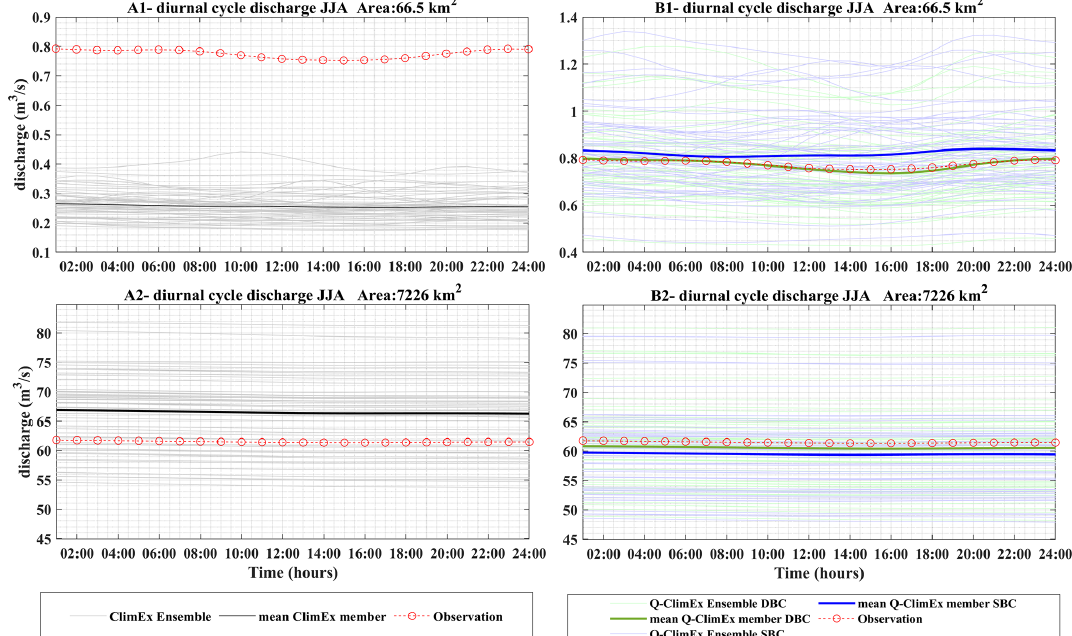
Figure 10. Annual diurnal cycle of discharge in JJA (June, July, August) before bias correction (left column: A1 and A2) and after bias correction (right column: B1 and B2) for two selected catchments. Top row is for catchment 02143040 (small size classification) and bottom row is for catchment 02156500 (large size classification). The observations are shown in red. Streamflow simulations using uncorrected ClimEx members are shown in light gray, and the ensemble mean is in black. Simulations using bias-corrected data are in light blue (SBC) and light green (DBC) with the corresponding dark colors showing the ensemble mean. Time shown is local time, with 24:00 corresponding to